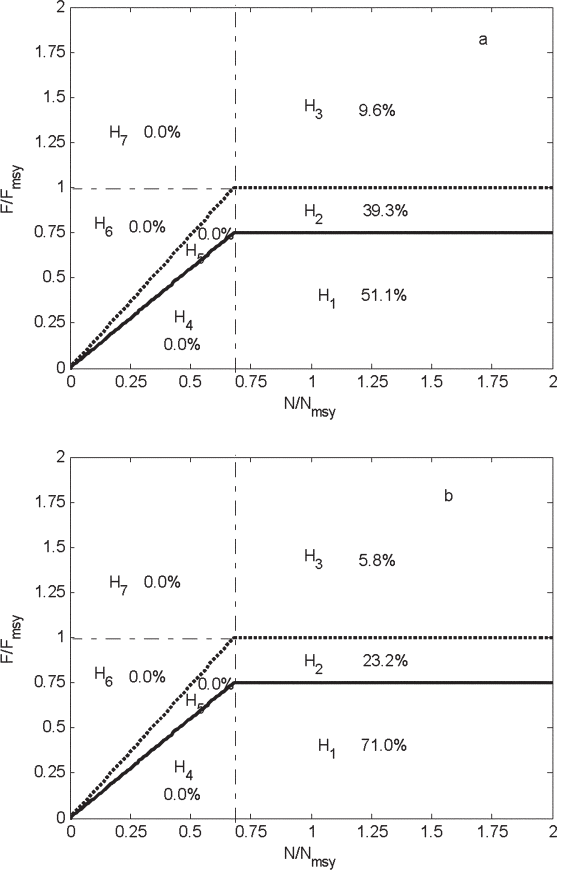
Fig . 2. – Fishery status and its uncertainty shown as the Target Limit Control Rule. Percentages in each region indicate the probability that the fishery was in that state in 2003 (a) and 2007(b). Solid thick line: target reference line; dotted thick line: limit reference